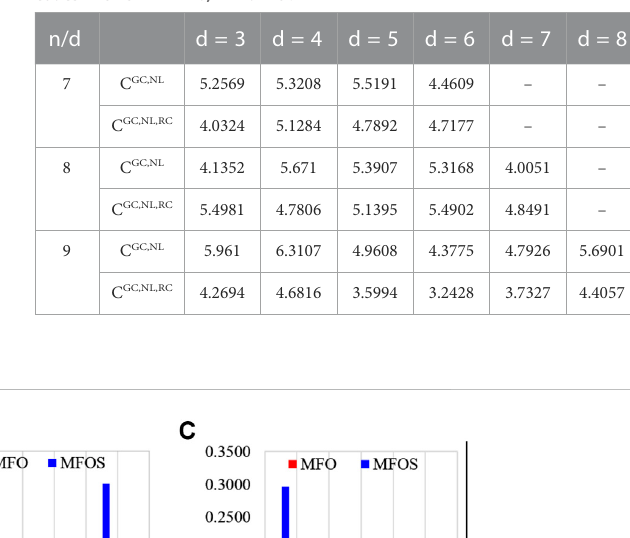
TABLE 6 Comparison of C GC,NL and C GC,NL,RC ( n,W,d ) for Tm variance of DNA codes with 5 < n < 10, 2 < d < 9.